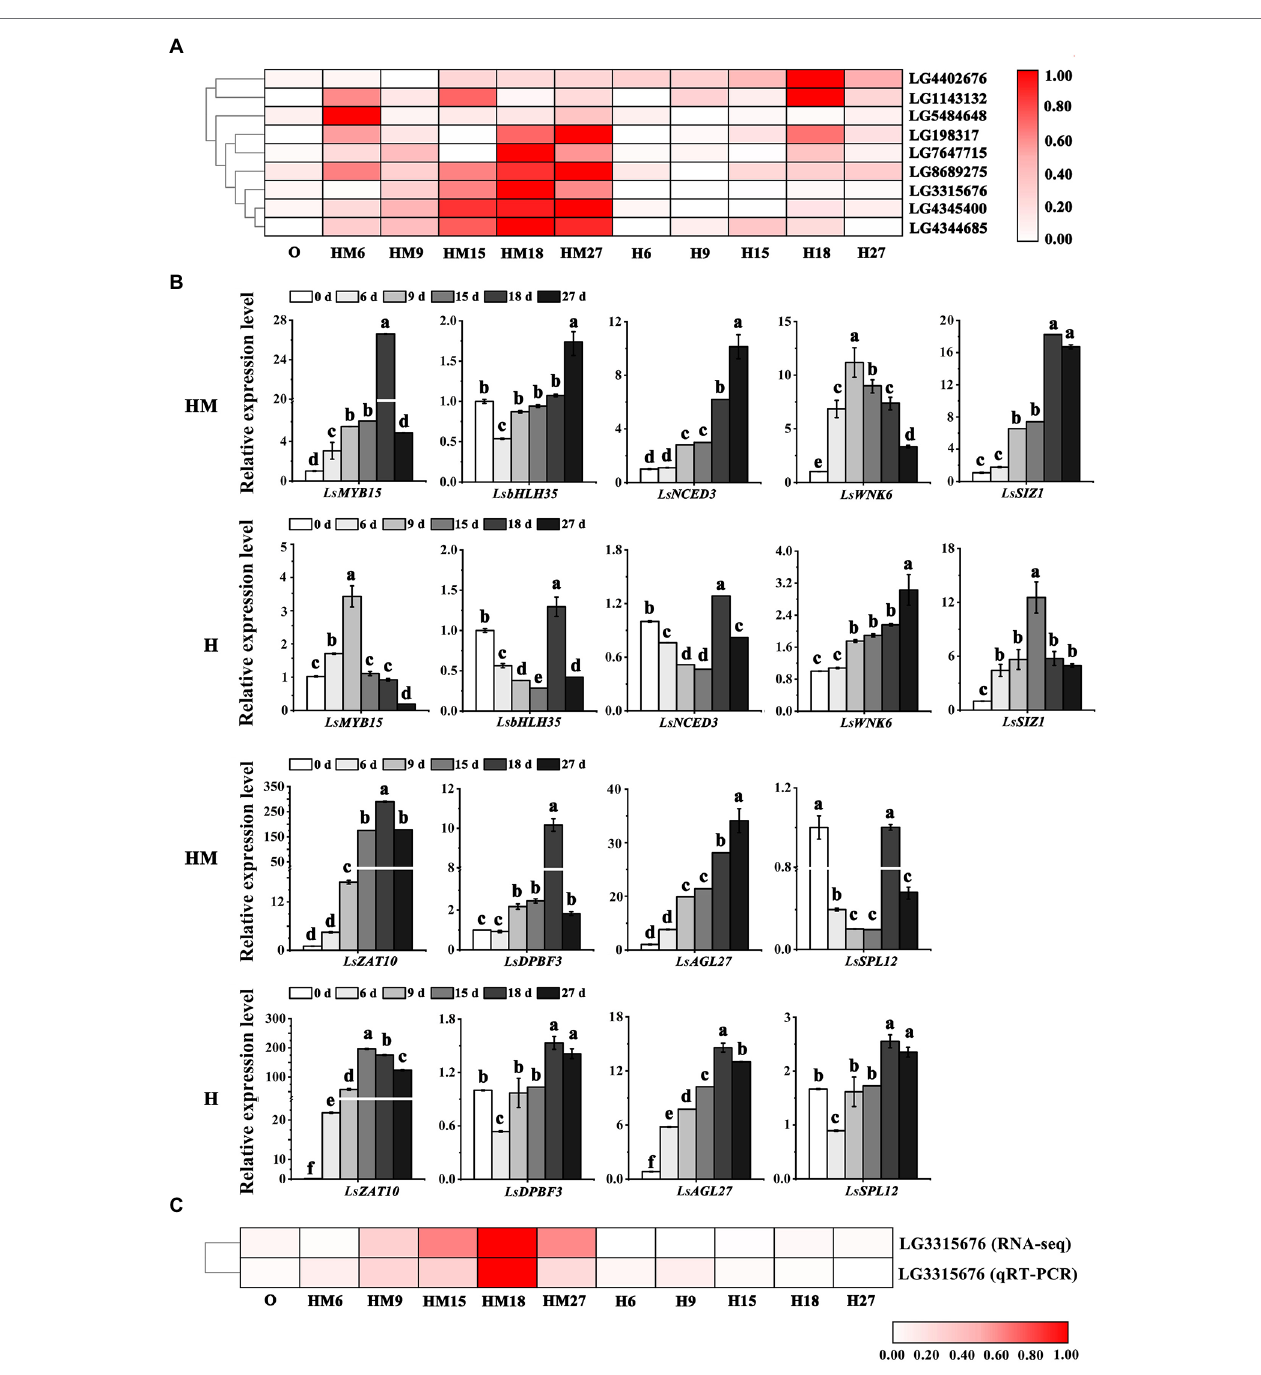
FIGURE 5 | Identification and analysis of bolting-related genes. (A) Heatmaps describing the expression profiles of candidate genes related to bolting-related genes. (B) Validation of RNA-seq expression profiles via qRT-PCR. (C) Correlation analysis between ABA-related genes and expression of the related candidate LsMYB15 (LG3315676) via RNA-seq and qRT-PCR data. “MH” represents 100 μ mol L − 1 melatonin treatment under high temperature, and “H” represents no exogenous melatonin treatment under high temperature. Different letters above the bars indicate significantly different values ( p < 0.05) calculated using one-way analysis of variance (ANOVA) followed by Tukey’s multiple range